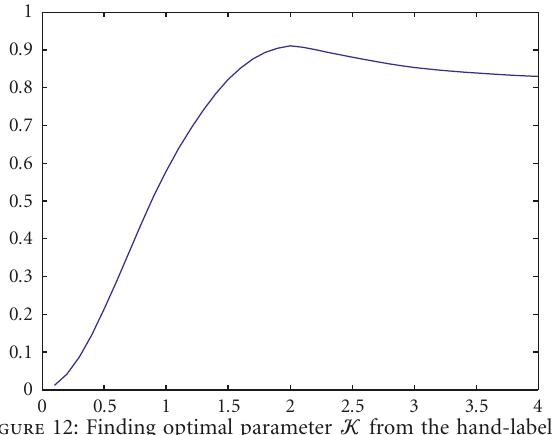
Figure 12: Finding optimal parameter K from the hand-labelled ground truth.